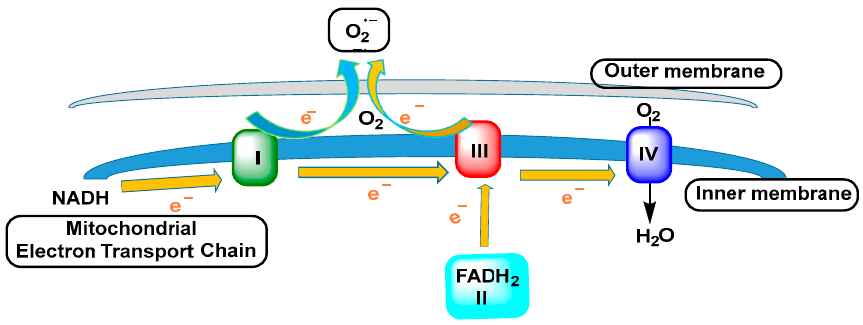
Figure 9. Superoxide radicals are produced in complexes I and III of the electron transport chain by transferring electrons to molecular oxygen.